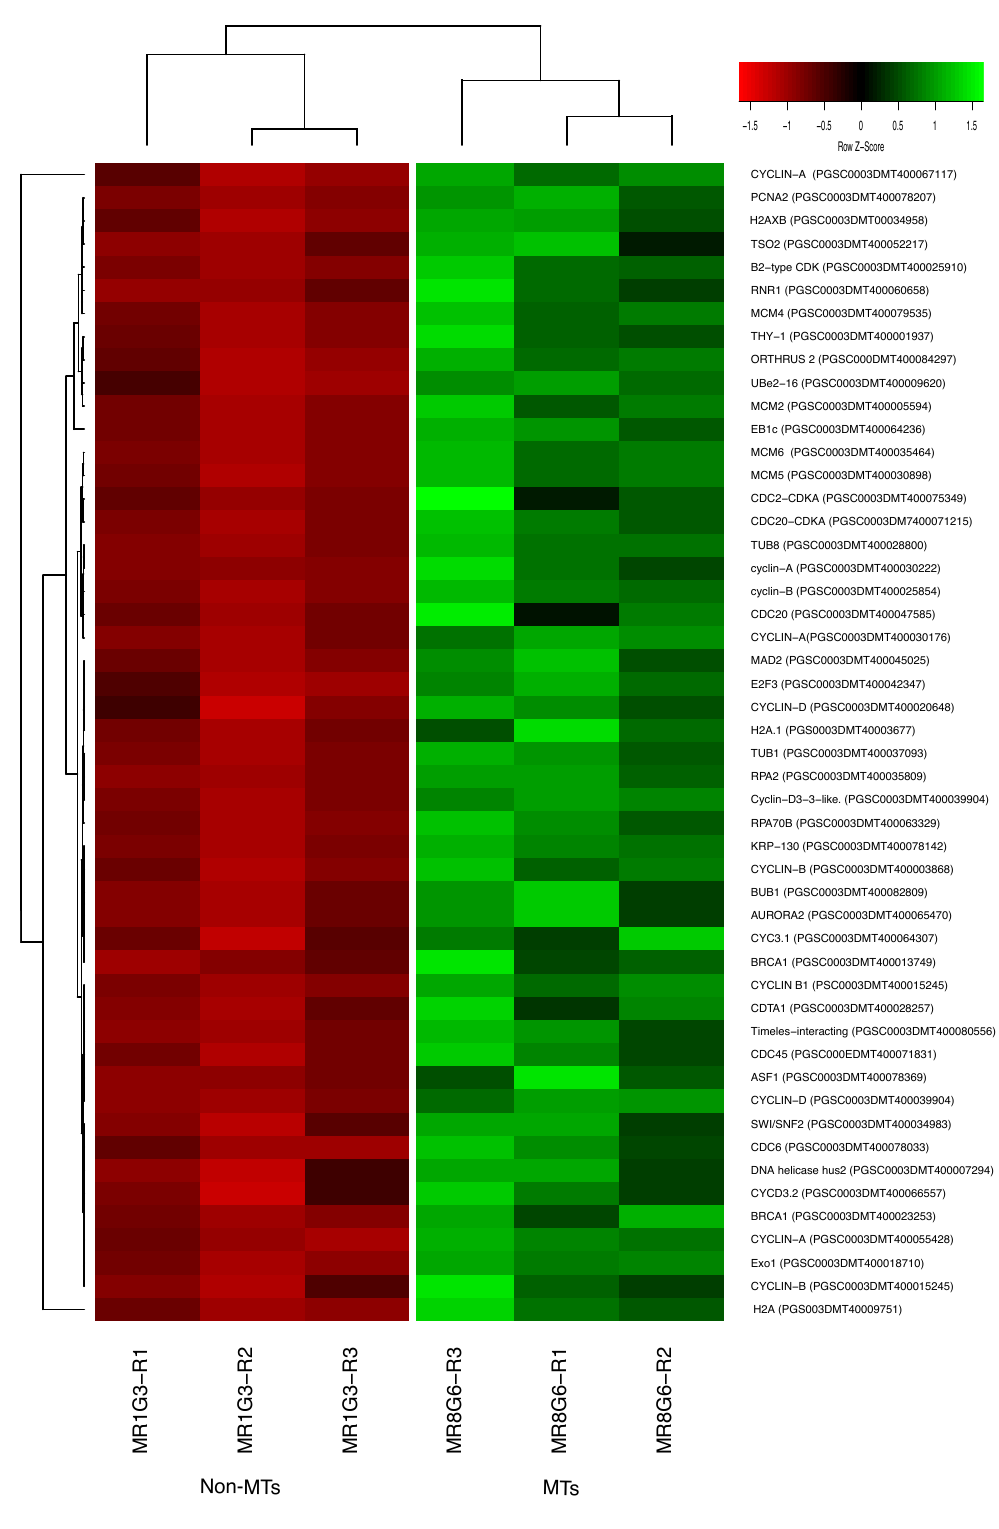
Figure 12. Heat map of CC regulation proteins during MTs development under dark conditions; levels of up-regulation are present in